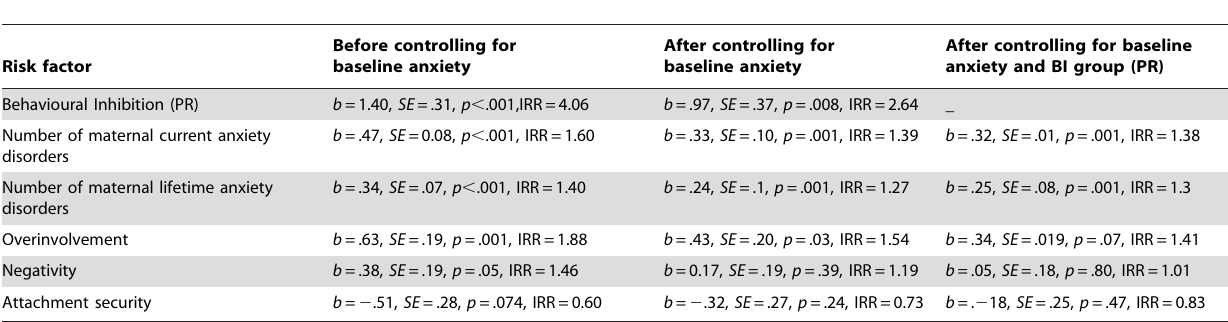
Table 3. Results of negative binomial regressions to assess the effect of each risk factor on the number of child anxiety diagnoses at 5-year follow-up.